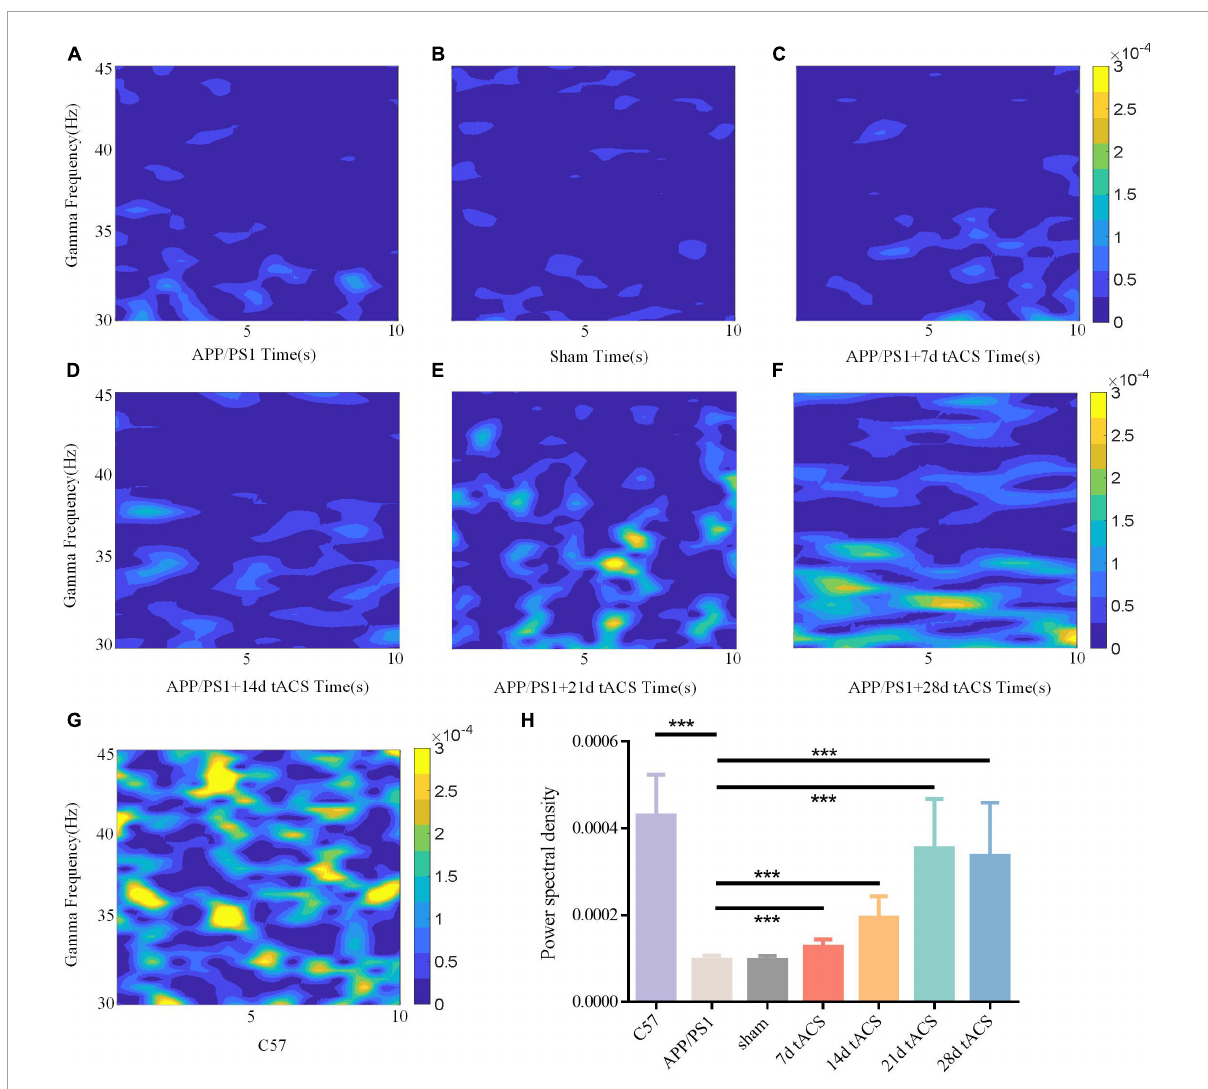
FIGURE5 (A) APP/PS1 group power spectrum, (B) sham group power spectrum, (C) 7-day APP/PS1 group power spectrum, (D) 14-day APP/PS1 group power spectrum, (E) 21-day APP/PS1 group power spectrum, (F) 28-day APP/PS1 group power spectrum, (G) C57 group power spectrum. (H) Spontaneous gamma power between different groups, * indicates P < 0.05, ** indicates P < 0.01. n = 5 mice for each group. The power spectral density of C57 group was 0.000433 ± 0.000127, APP/PS1 group was 0.000092 ± 0.000035, sham group was 0.00009 ± 0.000015, 7 days tACS group was 0.000138 ± 0.000055, 14 days tACS group was 0.000204 ± 0.000072, 21 days tACS group was 0.000377 ± 0.000141, and 28 days tACS group was 0.000364 ±